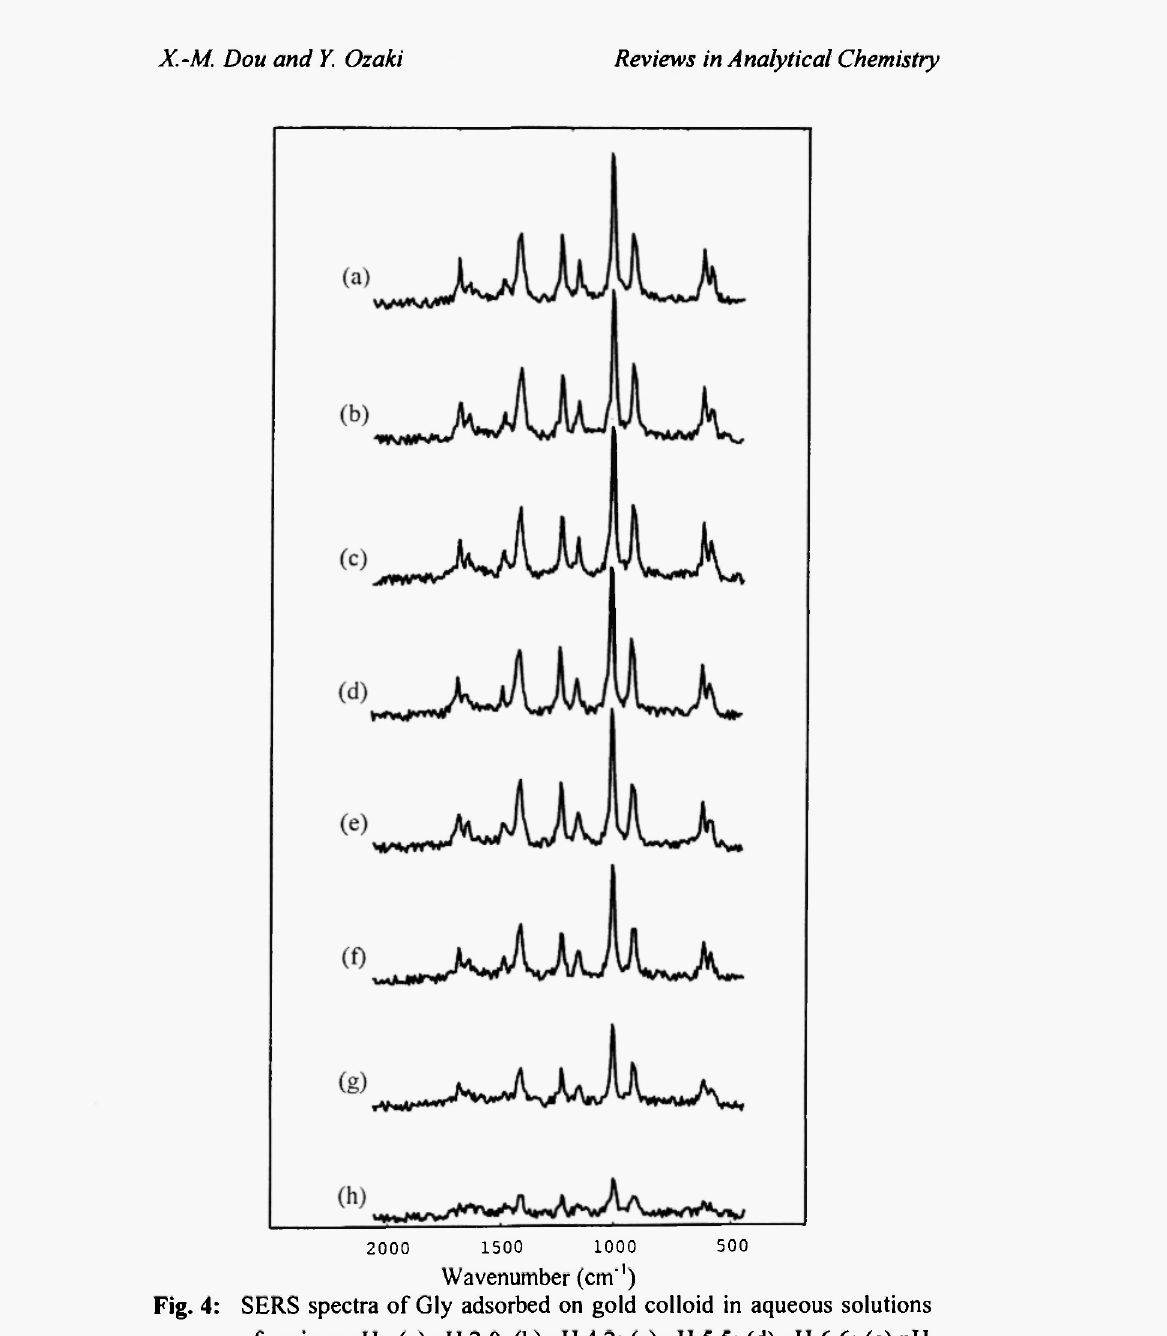
Fig. 4: SERS spectra of Gly adsorbed on gold colloid in aqueous solutions of various pH. (a) pH 2.0; (b) pH 4.2; (c) pH 5.5; (d) pH 6.6; (e) pH 7.5; (0 pH 8.2; (g) pH 10.0; (h) pH 12.0. (Reproduced from ref. 20 with